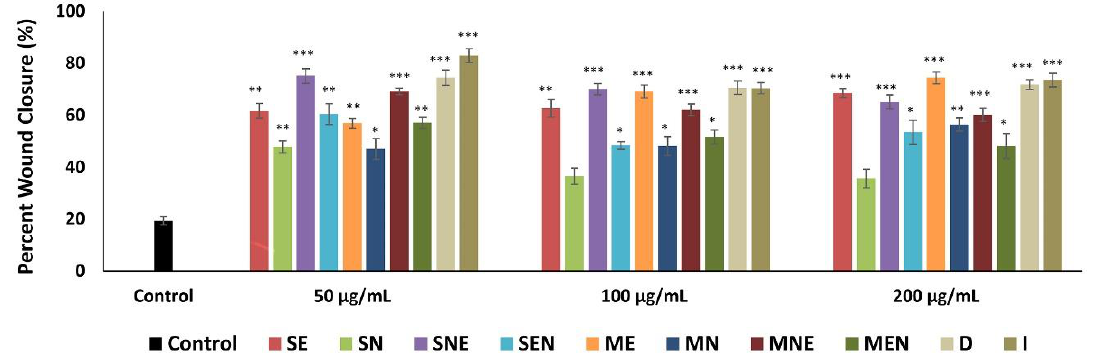
Figure 3. Wound closure percentage of fibroblasts after treatment with different concentrations (50, 100, 200 µg/mL) of TS extracts for 72 h. Untreated fibroblasts were used as control. Data were presented as mean ± SEM (n = 3) and compared with the control group, * p < 0.05, ** p < 0.01, *** p <